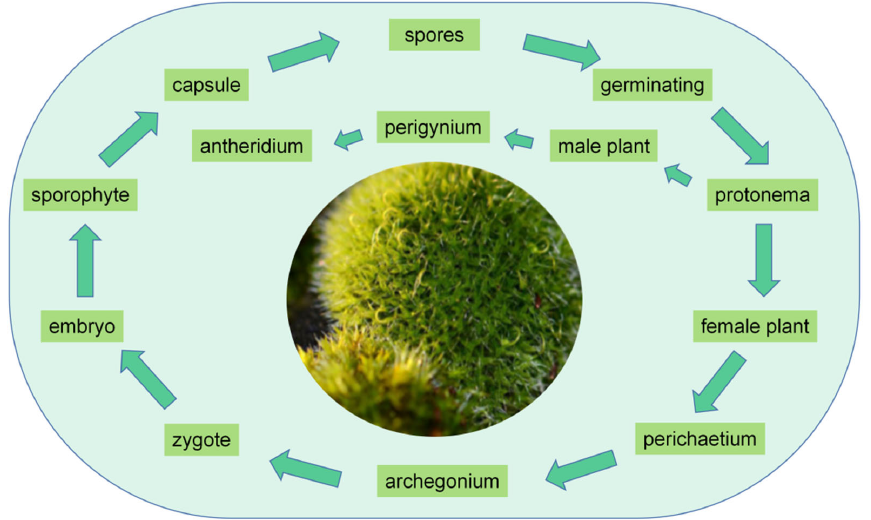
Figure 2. Moss morphology and life cycle (created by author).